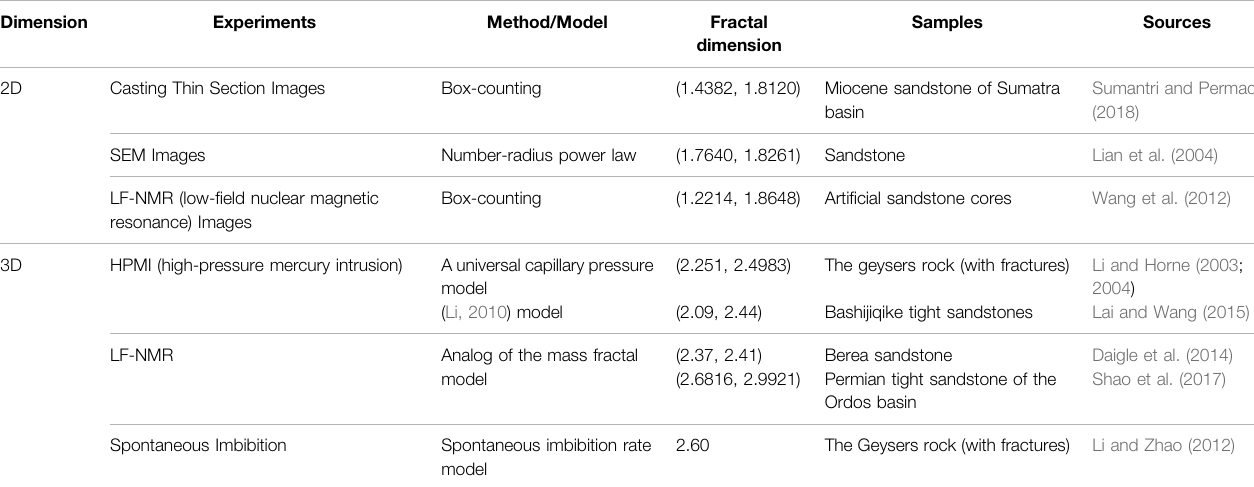
TABLE 1 | Several examples for fractal characterization of pore structure of (tight) sandstone.